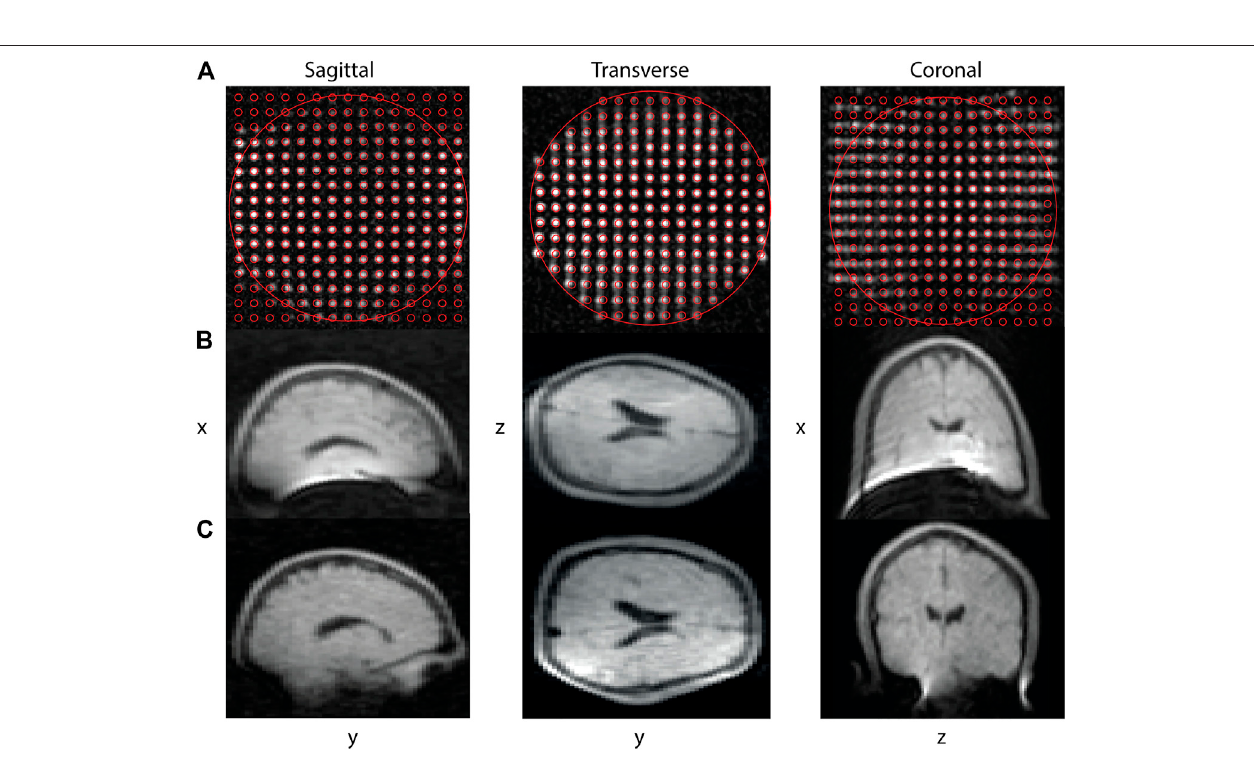
FIGURE 2 | Centre planes of a point source phantom imaged using a TSE sequence (A) . From left to right: Sagittal, transverse and coronal centre planes are displayed with the following acquisition parameters: 230 ( z : right-left) × 230 ( x : head-feet) × 230 ( y : posterior-anterior) mm 3 , data matrix: 150 × 150 × 150, TR/TE: 200/15 ms, echo train length: 6, scan duration 12 min 30 s. The small red circles denote the ground truth position of the point sources, the larger circle displays the 200 mm DSV. The lower part of the fi gure shows in vivo brain images of the same volunteer acquired with the old (B) and new gradient coils (C) . The slices are acquired using a TSE sequence with acquisition parameters: 180 ( z : right-left) × 240 ( x : head-feet) × 220 ( y : posterior-anterior) mm 3 , data matrix: 90 × 120 × 55, TR/TE: 400/15 ms, echo train length: 5, scan duration 9 min 36 s. For the in vivo and phantom images standard Fourier reconstruction with a sine bell squared fi lter are used.